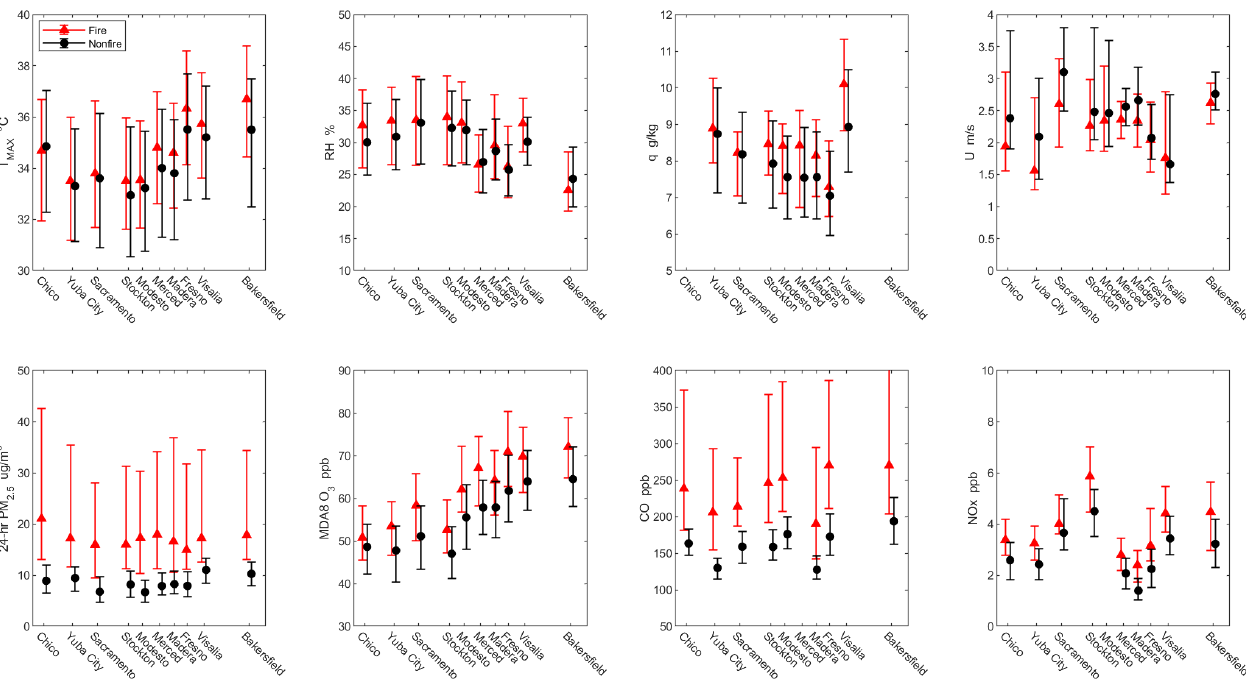
Figure 3. Median values for fire (red triangles) and non-fire (black circles) periods at each station; error bars represent 25th and 75th percentile values. RH, q , U , CO, and NO x are 5h averaged values between 10:00 and 15:00PST. The interval of station-axis labeling is scaled to the latitude of each site. The number of data points within each group of error bars are the same as the number of wildfire days and background days shown in Table C2, unless there are missing data.